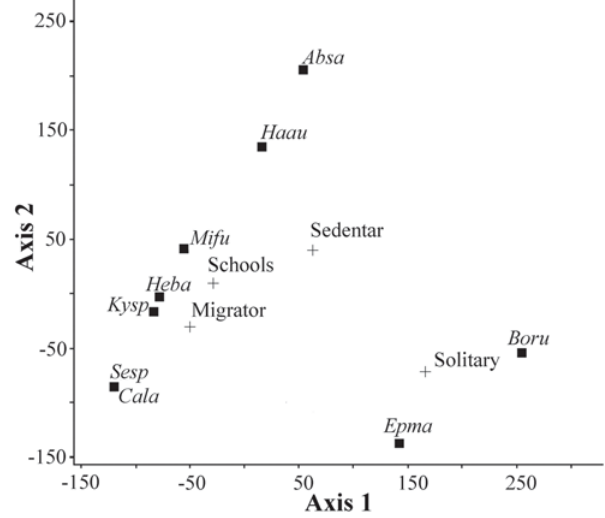
Fig. 5. Ordination plot of the correspondence analysis (first two axes) based on fishermen’s answers about migratory behavior of the nine studied fish species in the southeastern Brazilian coast: Absa = Abudefduf saxatilis ; Boru = Bodianus rufus ; Cala = Caranx latus ; Epma = Epinephelus marginatus ; Haau = Haemulon aurolineatum ; Heba = Hemiramphus balao ; Kysp = Kyphosus spp.; Mifu = Micropogonias furnieri ; Sesp = Seriola spp.